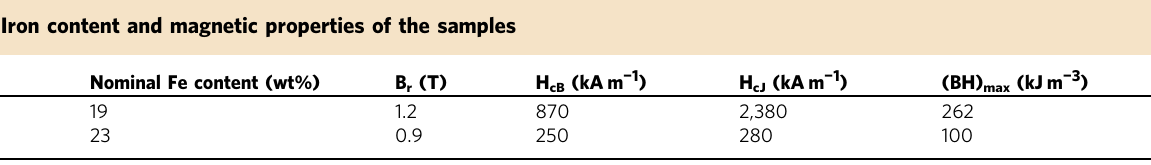
The data were extracted from demagnetization curves obtained at T = 20°C. The determined quantities are remanence (B r ), coercive fi eld strength at polarization equals zero ( H cB ), coercive fi eld strength at fl ux density equals zero ( H cJ ) and energy density (( BH ) max ). These values can be compared to the values provided by Maybury et al. 15